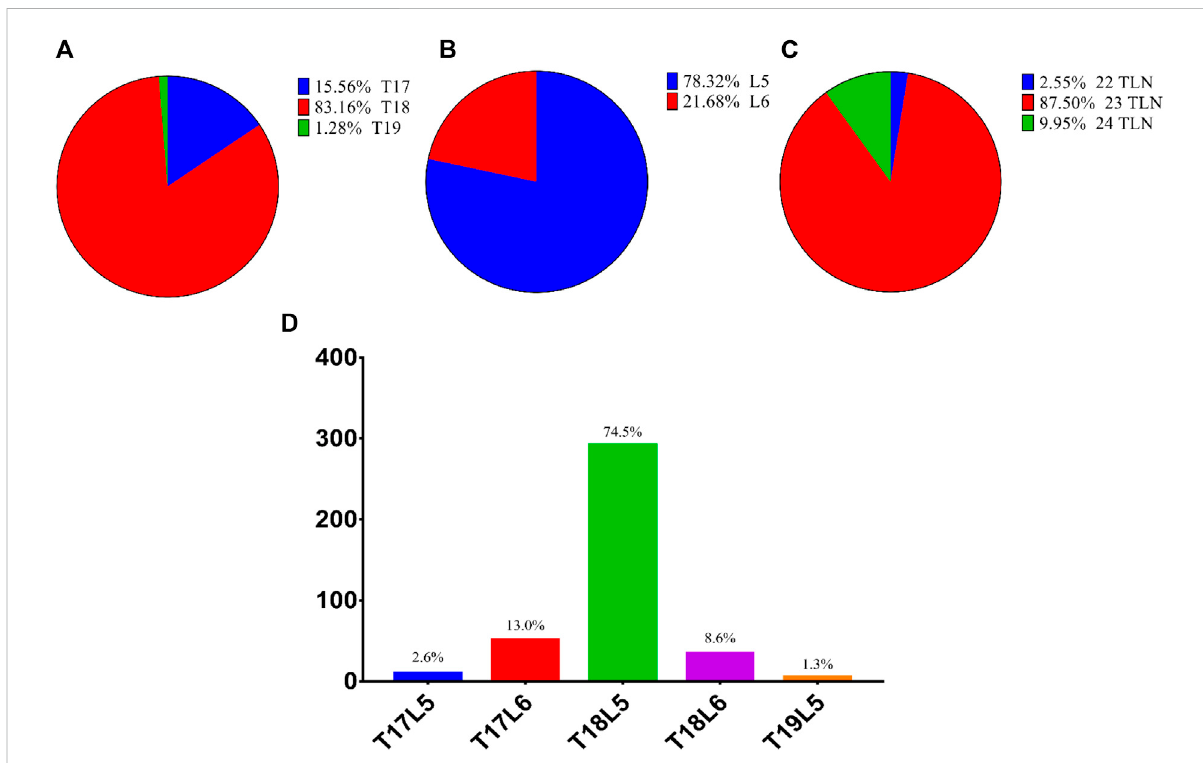
FIGURE 2 Variation in vertebral number of Dezhou donkeys. Notes: (A) variation in TN; (B) variation in LN; (C) variation in TLN; (D) variation in